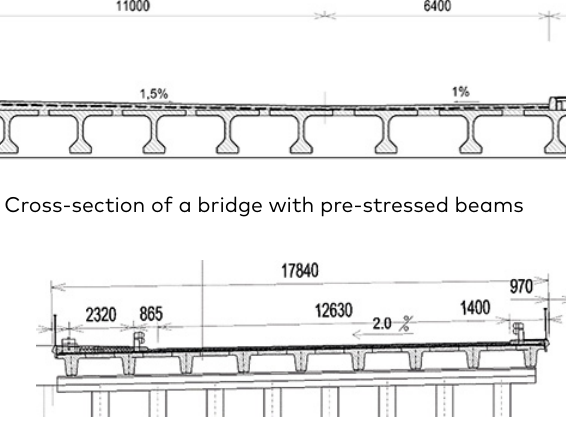
Figure 3. Cross-section of a bridge with trapezoidal cross-section beams